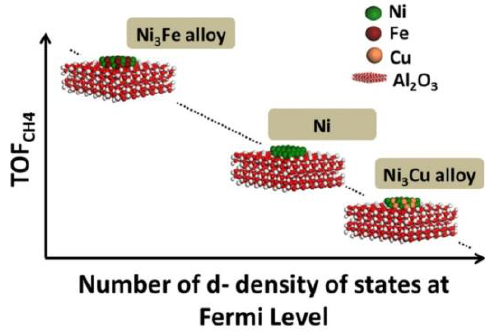
Figure 2. Linear correlation between the turnover frequency for CH 4 production (TOF CH4 ) and the number of d-density of states (d-DOS) at Fermi level (N EF ) for Ni, Ni 3 Fe and Ni 3 Cu catalysts. Reproduced with permission from [38]. Copyright: Elsevier, Amsterdam, The Netherlands, 2017.